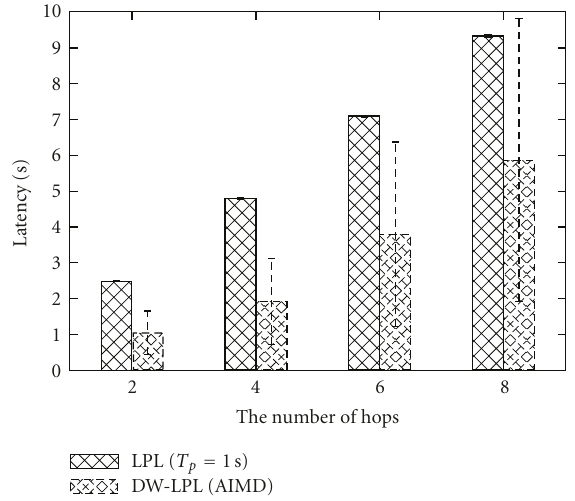
Figure 11: The experiment result on packet latency in multihop